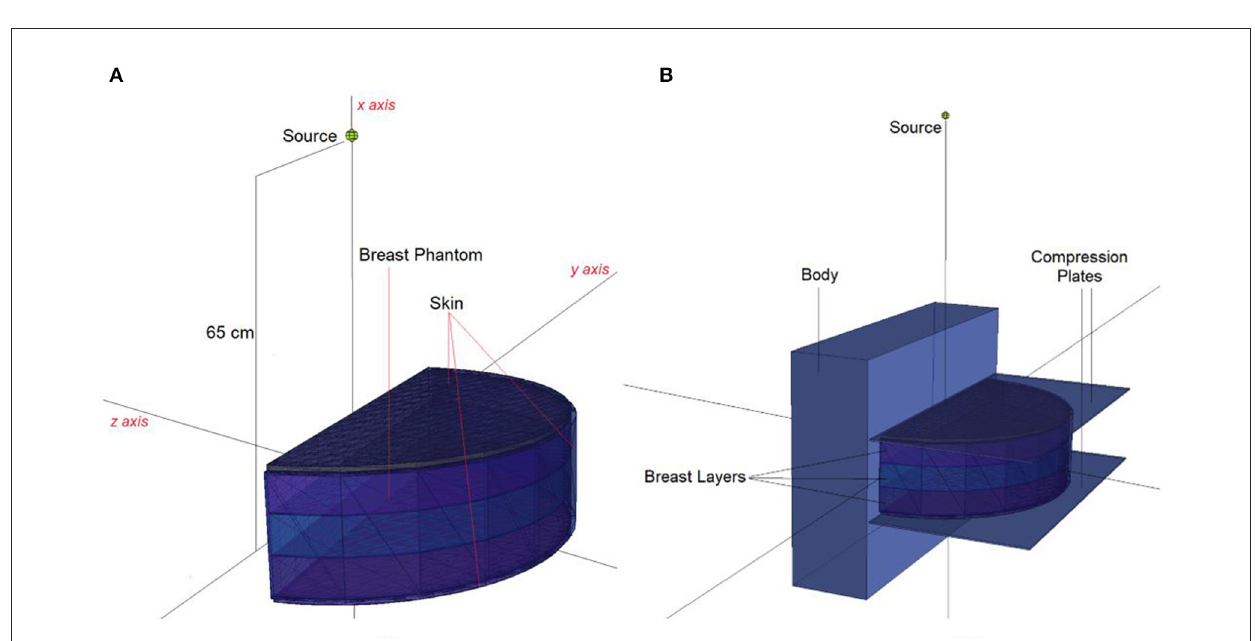
FIGURE2 3-D view of modeled MCNPX simulation setup from (A) breast phantom (B) breast phantom with body phantom and compression plates ( via MCNPX Visual Editor X22S).